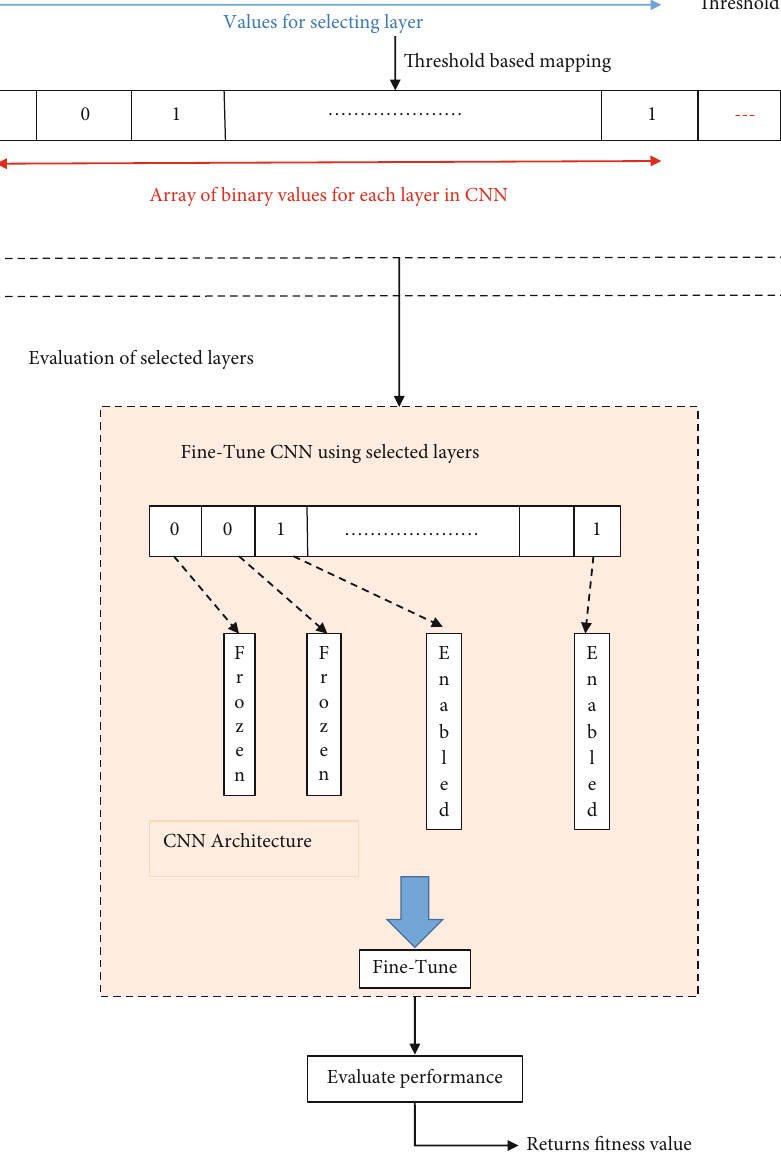
Figure 3: Fine tuning of the convolutional